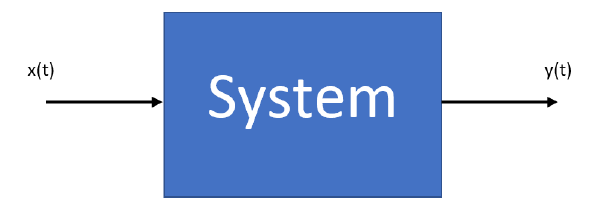
Figure 1. Linear time-variant system,